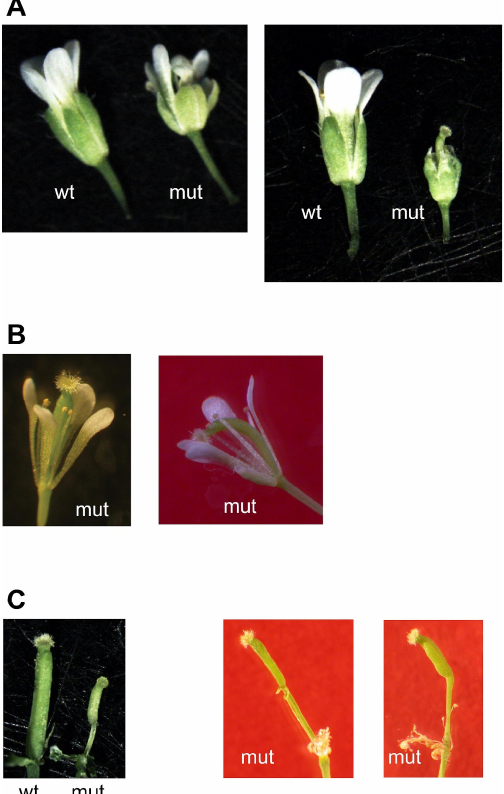
Figure 6. Altered flowers in double homozygous plants with drastic reduction of MIT expression . ( A ) Two different flowers from double homozygous mit1 ‐ 1 mit2 ‐ 1 plants (mut) were compared with wild type (wt) flowers: smaller sepals, smaller petals, lack of anthers (right panel) were visible. ( B ) Two additional mutated flowers from which sepals have been excised: the four petals are heteroge ‐ neous in shape, abnormally positioned (right panel), only four and three anthers are present, pistil appears either normal (left panel) or curved (right panel). ( C ) Sepals, petals, and anthers have been excised from wild type and mutated flowers; pistils with a stem ‐ like base are frequent in mutated flowers.